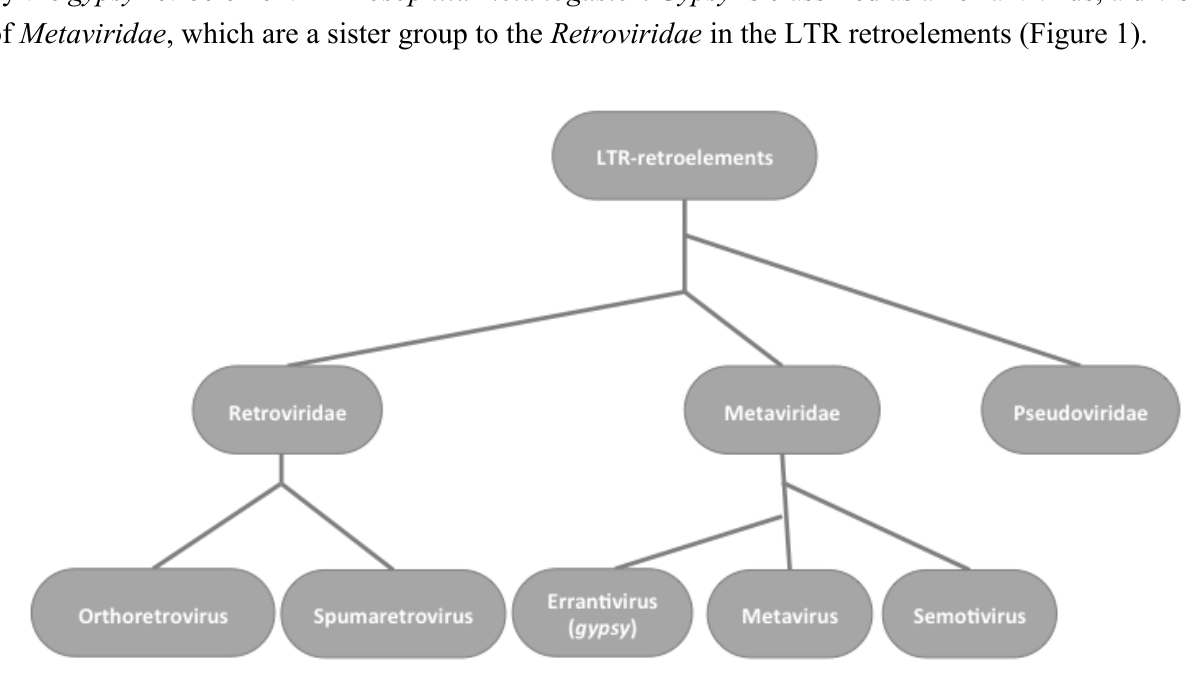
Figure 1 . Phylogenetic relationships between LTR-retroelements based on Reverse Transcriptase